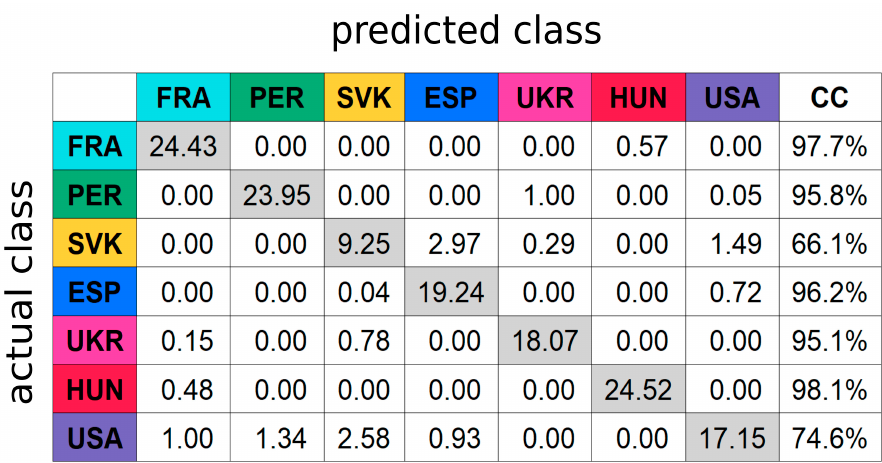
Table 1. Classification results of two class RF models (one country vs. rest, 100 repeated 10-fold CV) using only the 20 identified marker substances, after pareto scaling as